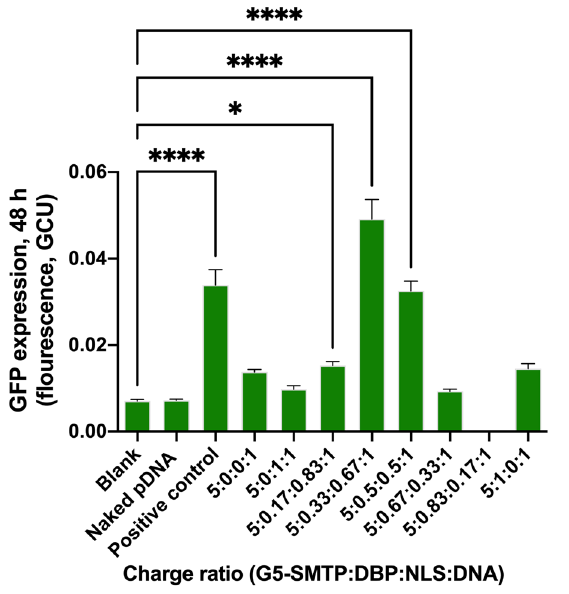
Figure 6. Nanocarrier polyplexes can deliver µDys–GFP in C2C12 cells. C2C12 cells were treated with the polyplexes formed at various charge ratios and the EGFP expression was quantified by measuring fluorescence after 48 h. Lipofectamine 2000 was used as the positive control. * denotes significance p ≤ 0.05, **** denotes significance p ≤ 0.0001.